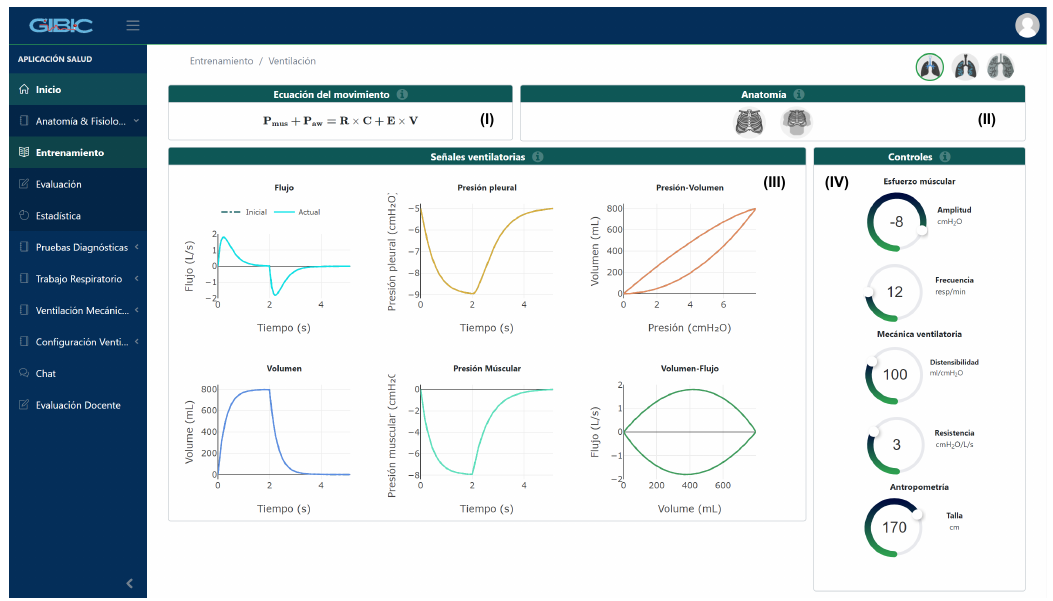
Figure 2. Graphical interface of the “Anatomy and Physiology” module with its sections: ( I ) equation of motion, ( II ) anatomy description and information, ( III ) ventilatory signals, and ( IV ) user controls.